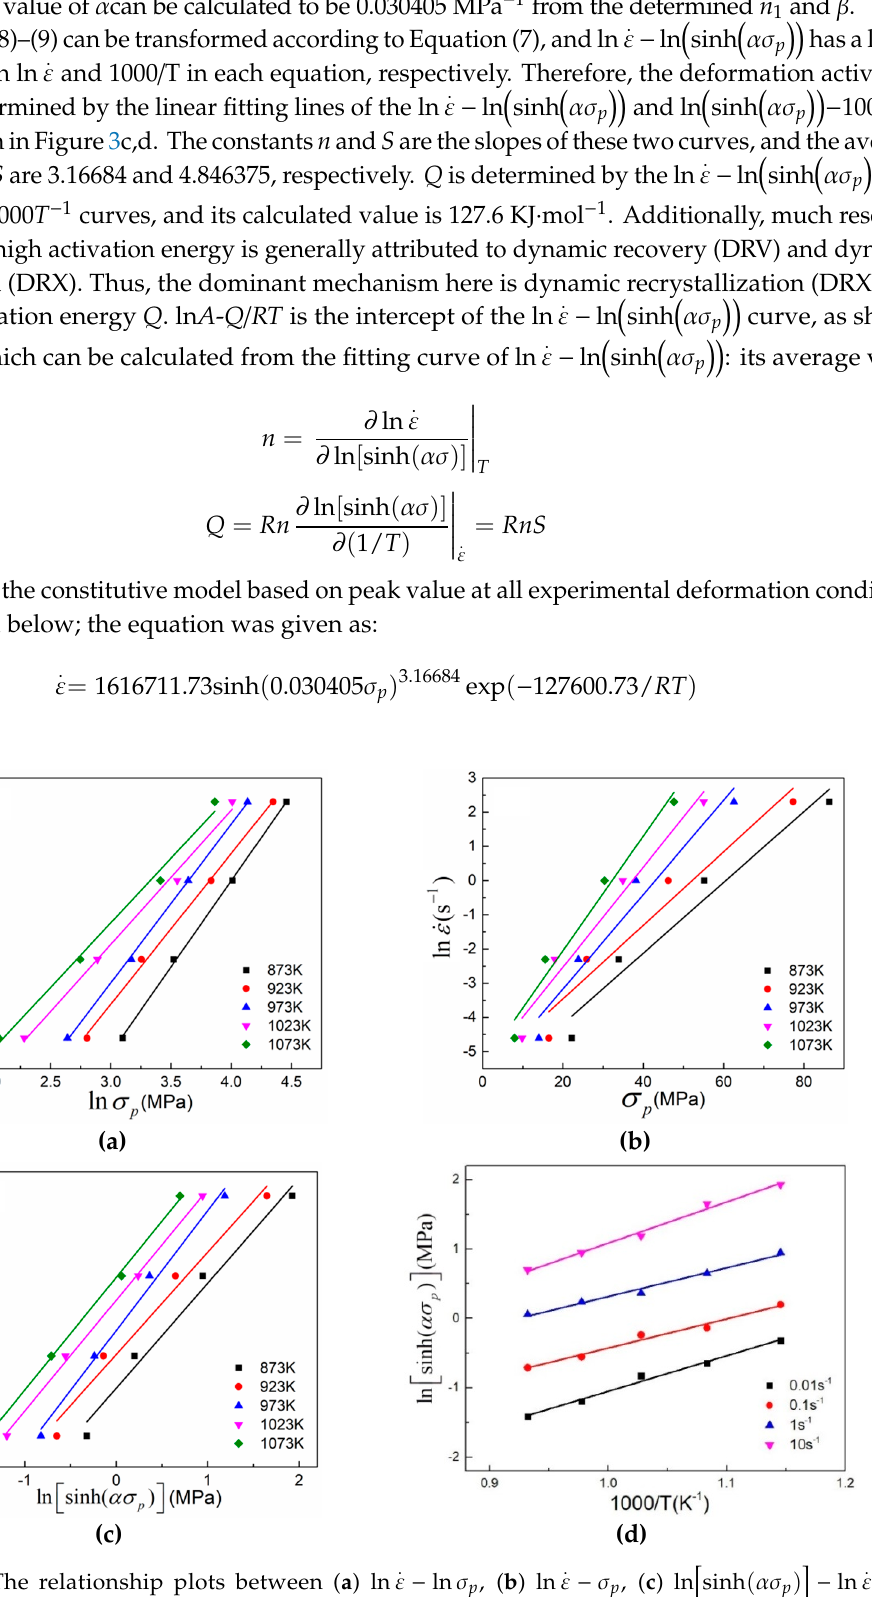
Figure 3. The relationship plots between ( a ) ln